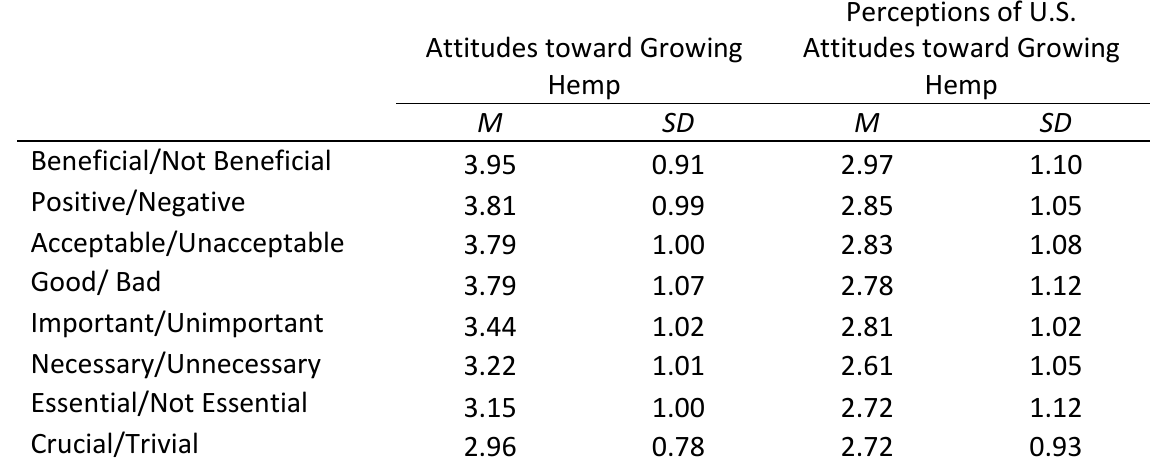
Attitude Toward Hemp and Perceptions of U.S. Attitudes Toward Hemp